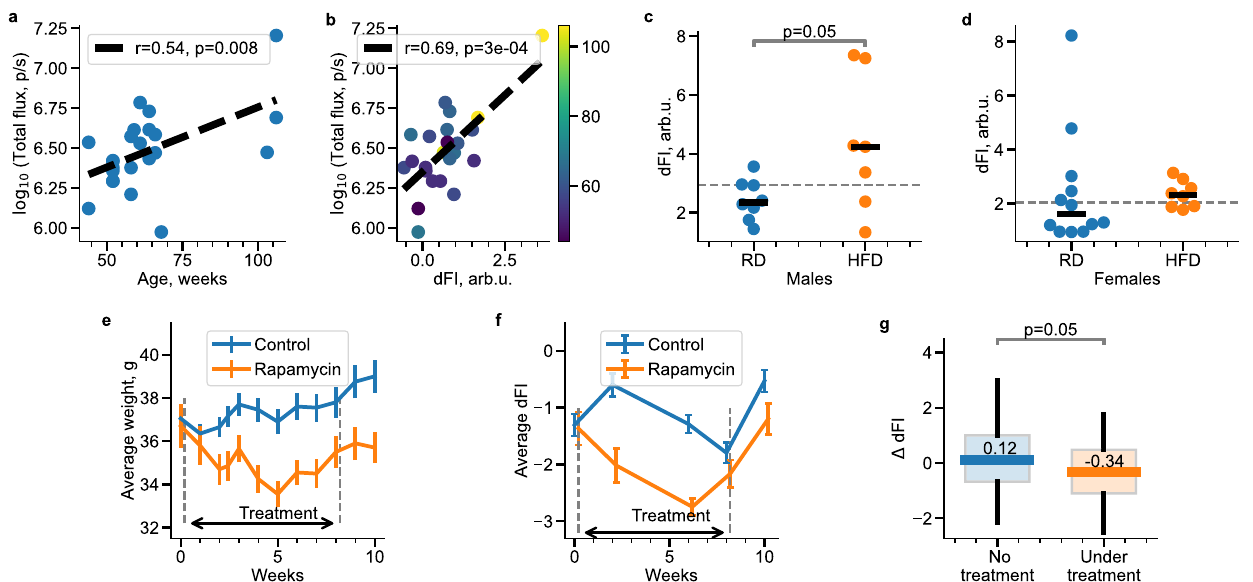
Fig. 6 | dFI is associated with senescent cells burden and responds to lifespan modulating interventions. Total fl ux (TF) in log scale represents p16-dependent luciferase reporter activity, is a quantitative indicator of senescent cells burden, and shows statistically signi fi cant correlations with age (Pearson ’ s r =0.54, two- sided p =0.008, n =23 animals) ( a ) and with dFI (Pearson ’ s r =0.69, two-sided p =0.0003, n =23 animals) ( b ) in old mice (>50 weeks). The colorbar in b represents animal age in weeks. dFI responds to the lifespan-modifying effect of high-fat diet (HFD): the dFI values (dots) were obtained late in life (at week 78) for male( c )andfemale( d )micefedwithRDorHFD.Thehorizontalbarandthedashed lines indicate the mean values in the groups and for all animals, respectively. dFI wassigni fi cantlyhigherinmaleswithHFD( n =7animals)vsRD(two-sided p =0.05, Student ’ s t test, n =8animals),buttherewasnosigni fi cantdifferencebetweenHFD ( n =8 animals) and RD ( n =12 animals) groups of female mice. The dFI